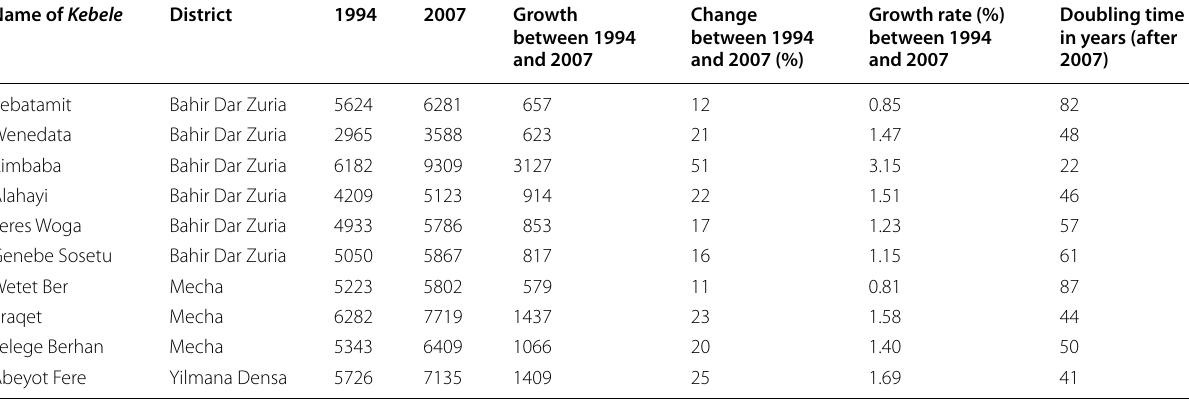
Table 9 Population number and growth rate in the sample Kebeles of the Andassa